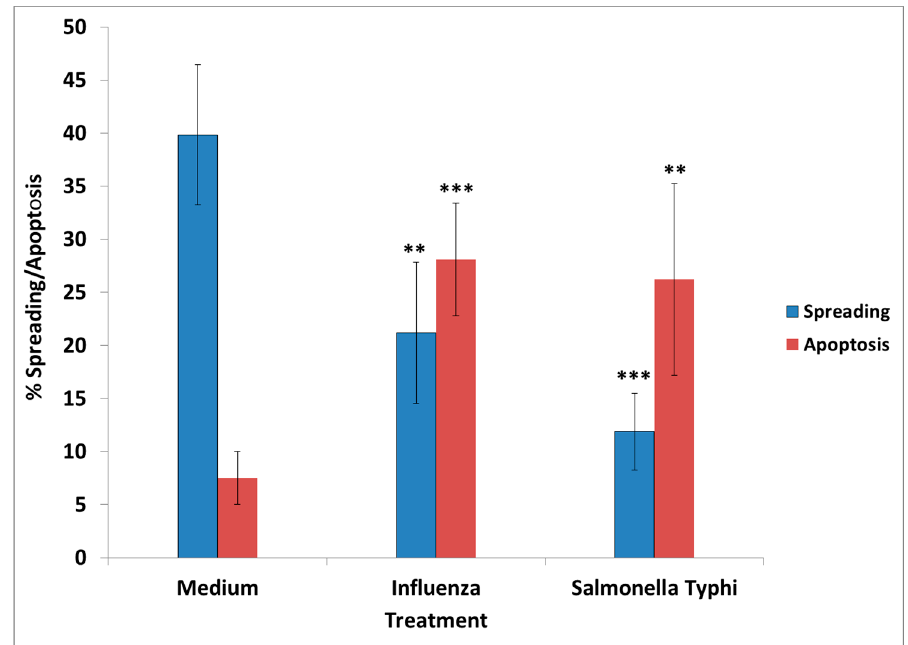
Figure 3. Percentage spreading and apoptosis of N2A in the presence of influenza and S. Typhi vaccine. ** p < 0.001, *** p < 0.0001 (compared to the medium). Spreading was decreased >15% by influenza and >25% by S. Typhi ; apoptosis was increased >25% by influenza and >20% by S. Typhi .